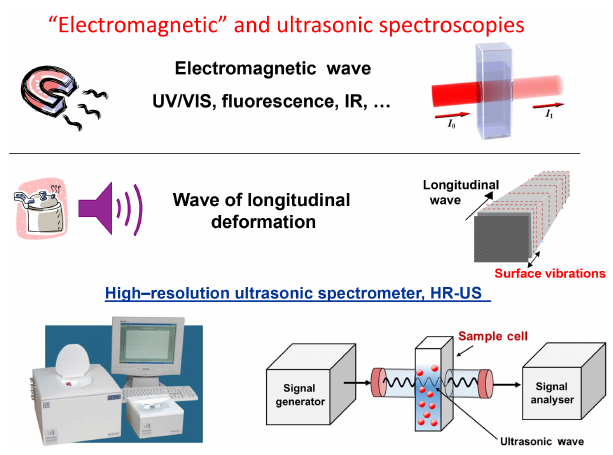
Figure 1. Illustration of principles of high-resolution ultrasonic